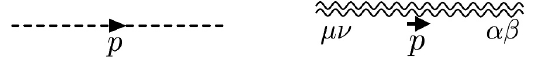
Figure 1 . Scalar (left) and graviton (right)